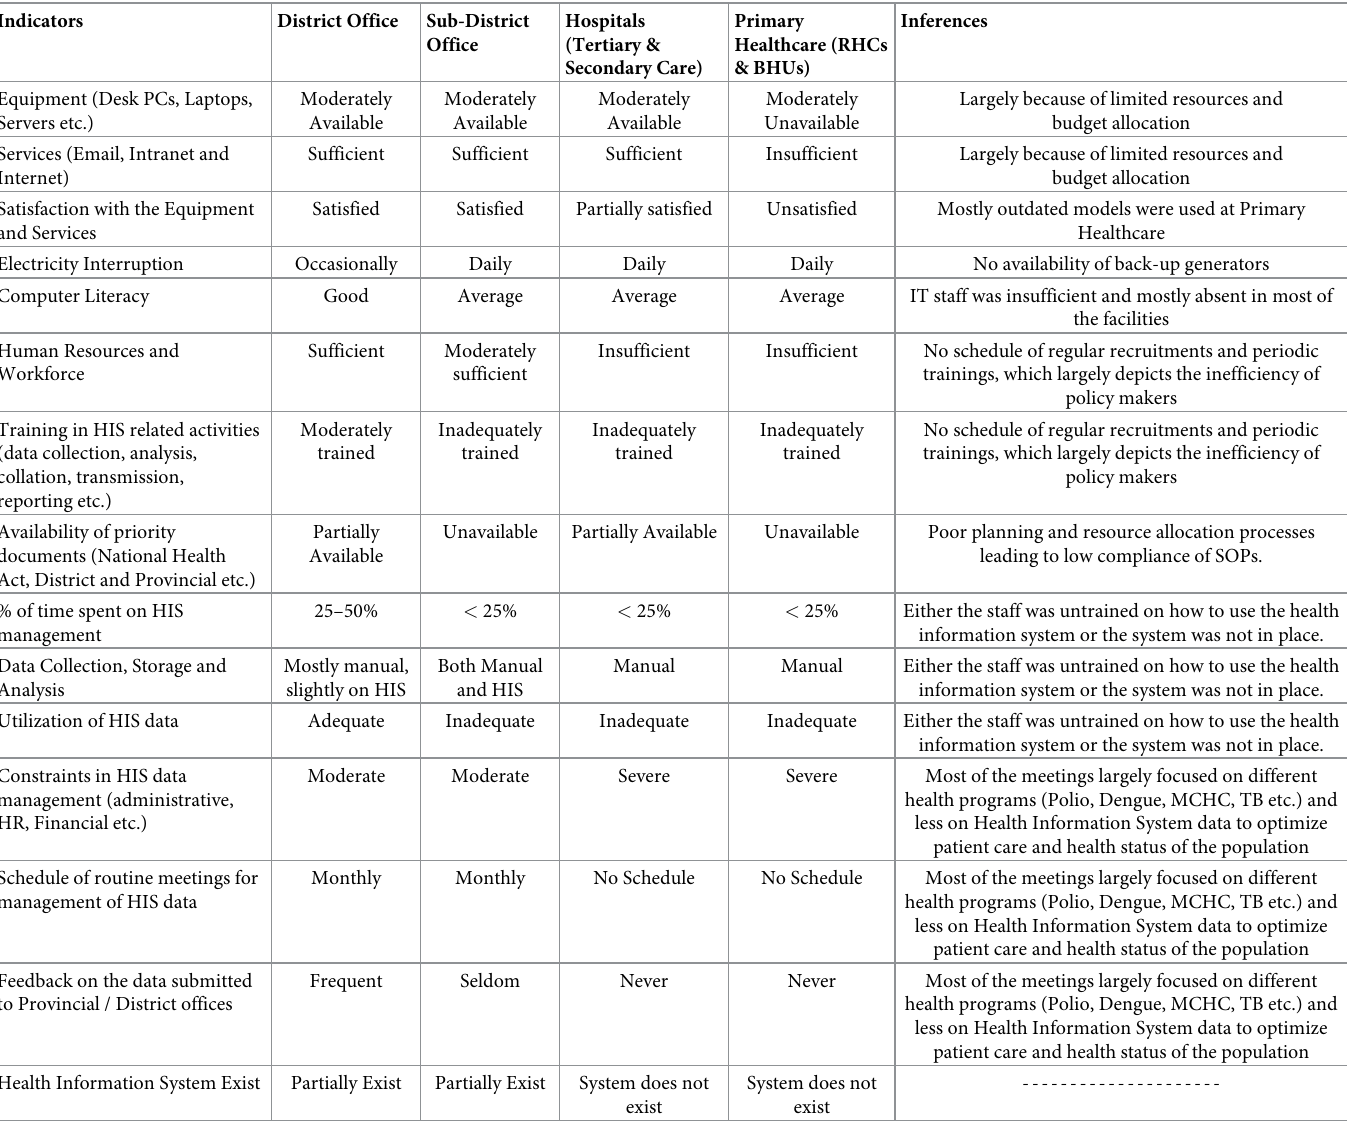
Table 10. Comparison of health information system among different healthcare